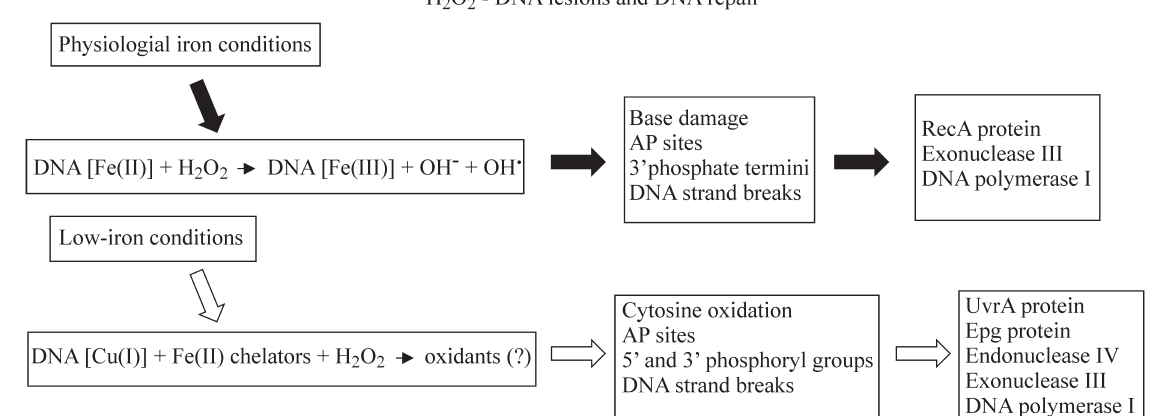
Figure 2 - DNA lesions and DNA repair in physiological and low-iron